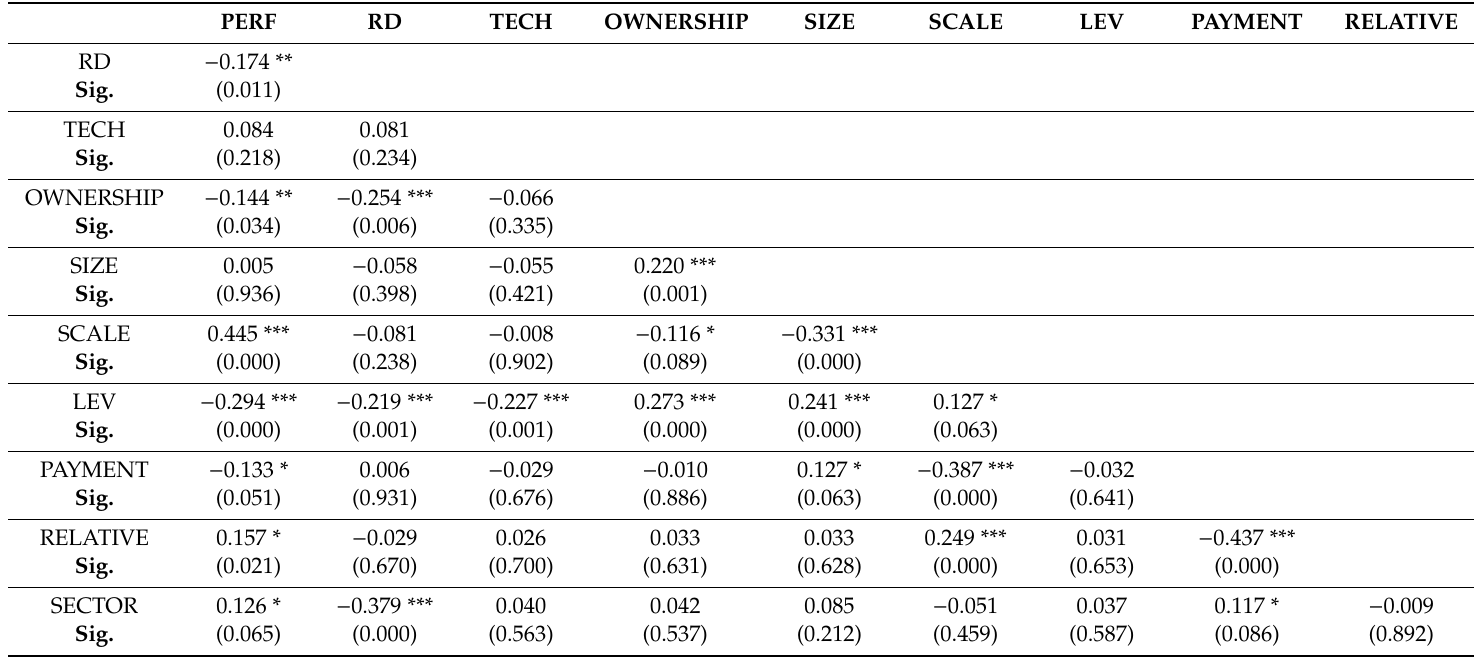
Table 4. Coe ffi cients and p -values of all variables in the correlation